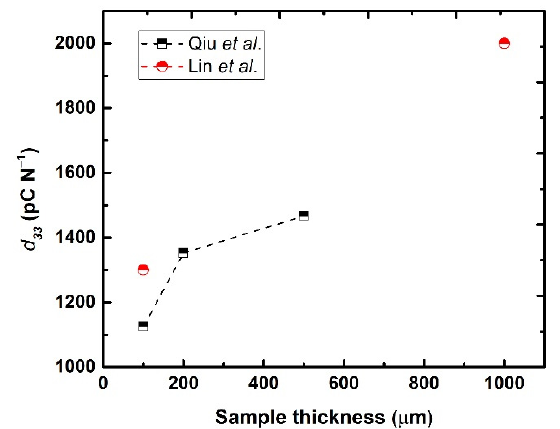
Figure 9. Longitudinal piezoelectric coefficient of PMN-PT single crystal is a function of sample’s thickness [207,211].